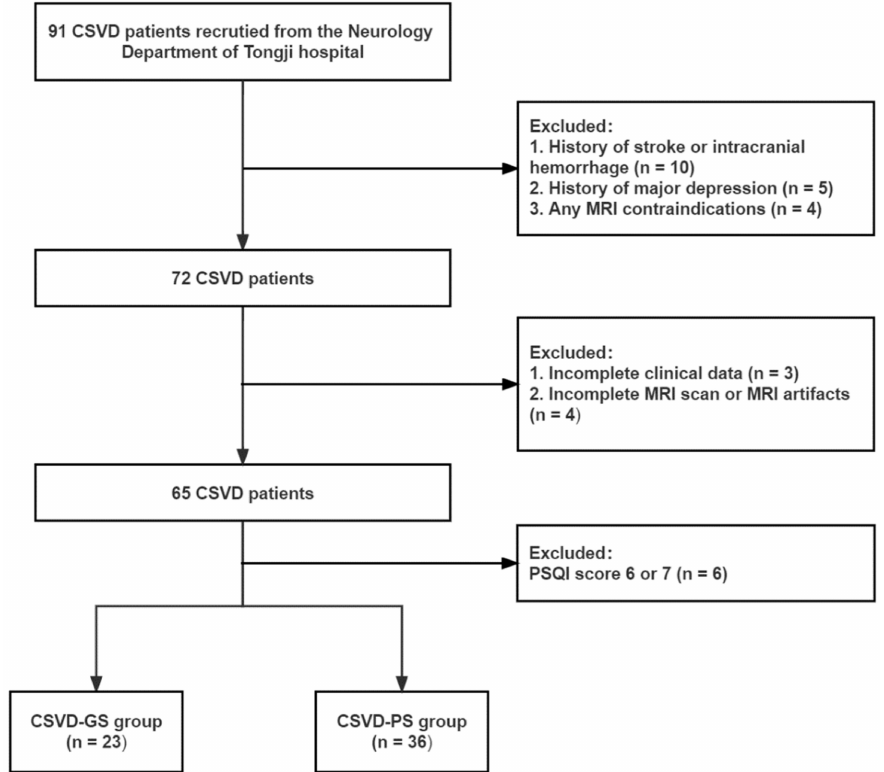
Figure 1. Flowchart of CSVD patient selection. CSVD—cerebral small vessel disease; MRI—magnetic resonance imaging; PSQI—Pittsburgh Sleep Quality Index; PS—poor sleepers; GS—good